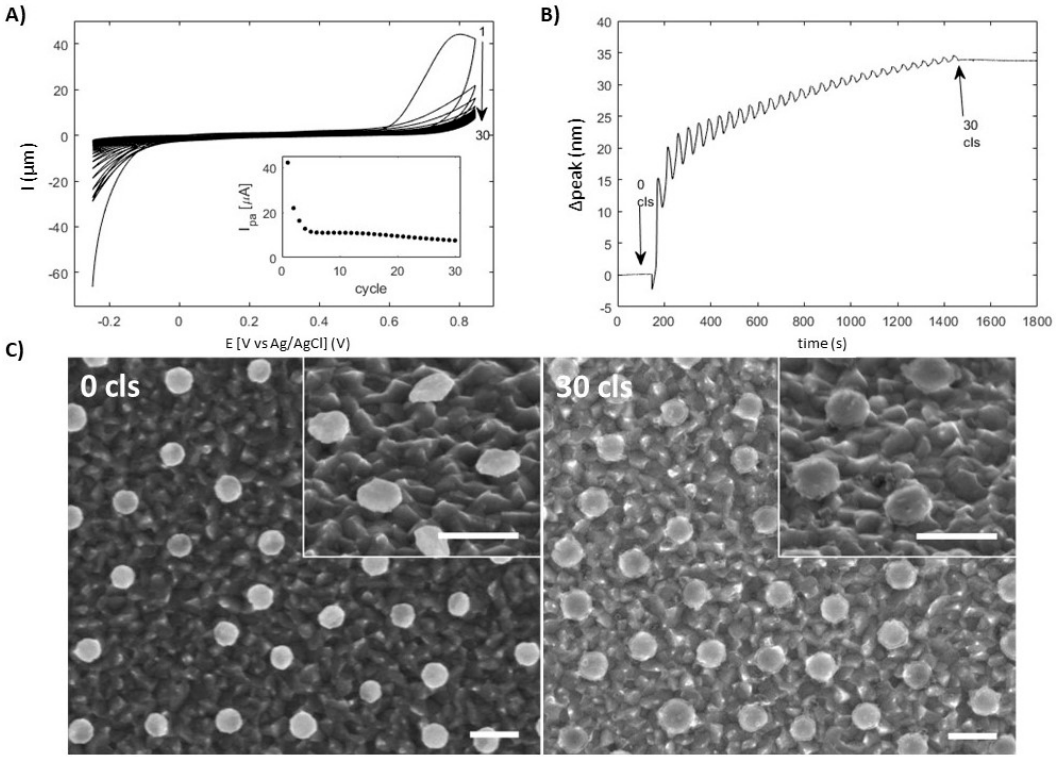
Figure 6. Poly(3-aminophenol) deposition on under-etched gold nanodisk-patterned ITO substrate without titanium adhesion layer. ( A ) CV curves for 30 cycles of electropolymerization with current at 850 mV as a function of deposition cycle (insert). ( B ) Resonance peak position as a function of time during deposition. ( C ) SEM images of under-etched gold nanodisks before and after 30 deposition cycles. Inserts are taken at an angle of 45°. Diameter increase after 30 cycles is roughly 21 nm. Scale bars are 200 nm.